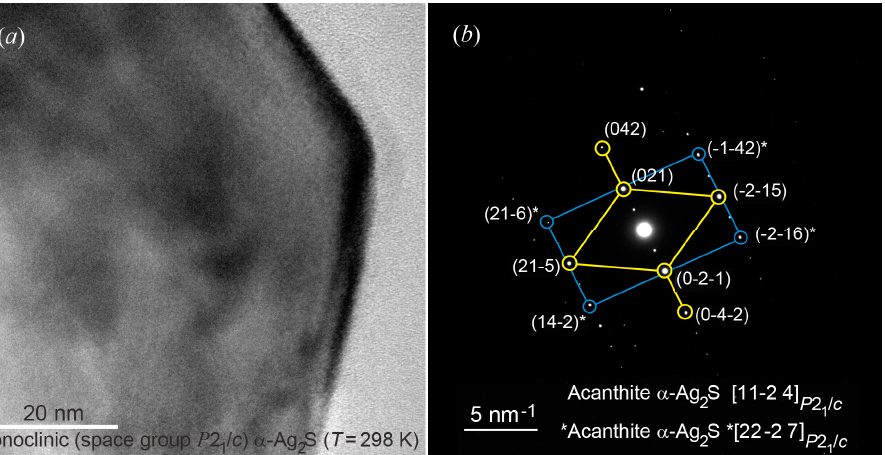
Figure 16. ( a ) HRTEM image of large colloid nanoparticle of α -Ag 2 S acanthite in size ~60 nm at 298 K, and ( b ) multiple electron diffraction pattern of this HRTEM image. Electron diffraction pattern ( b ) contains the reflections of different monoclinic α -Ag 2 S nanoparticles (the zone axis [ 11-24 ] and the zone axis ∗ [ 22-27 ] P 2 1 / c